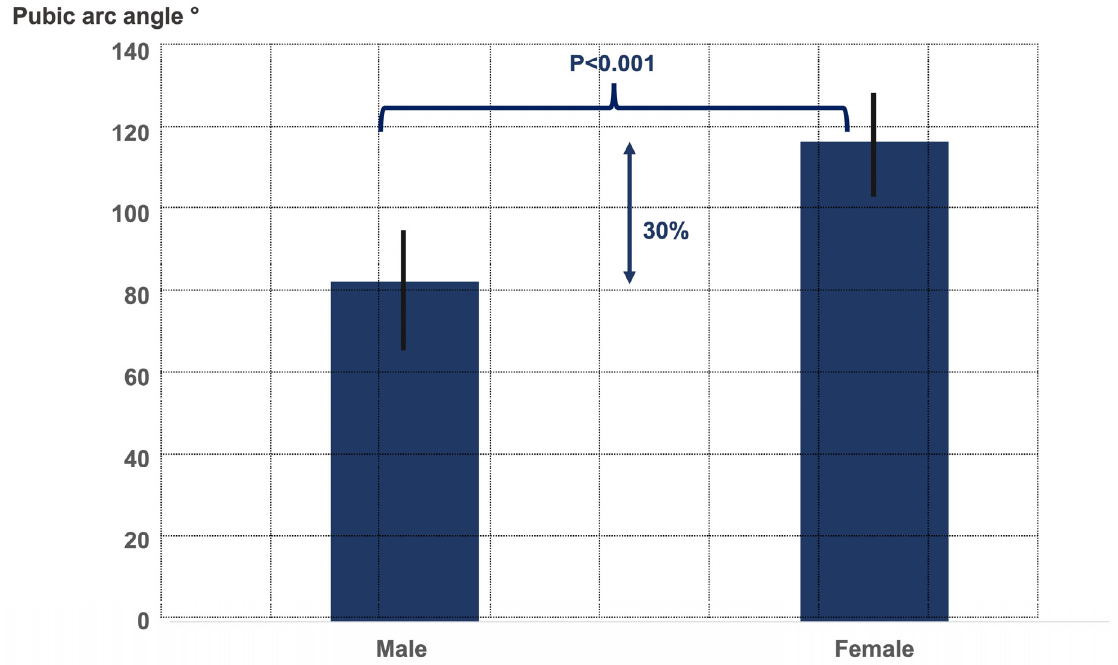
Figure 3. Graph illustrating the pubic-arc angle (subpubic angle) in males and females.